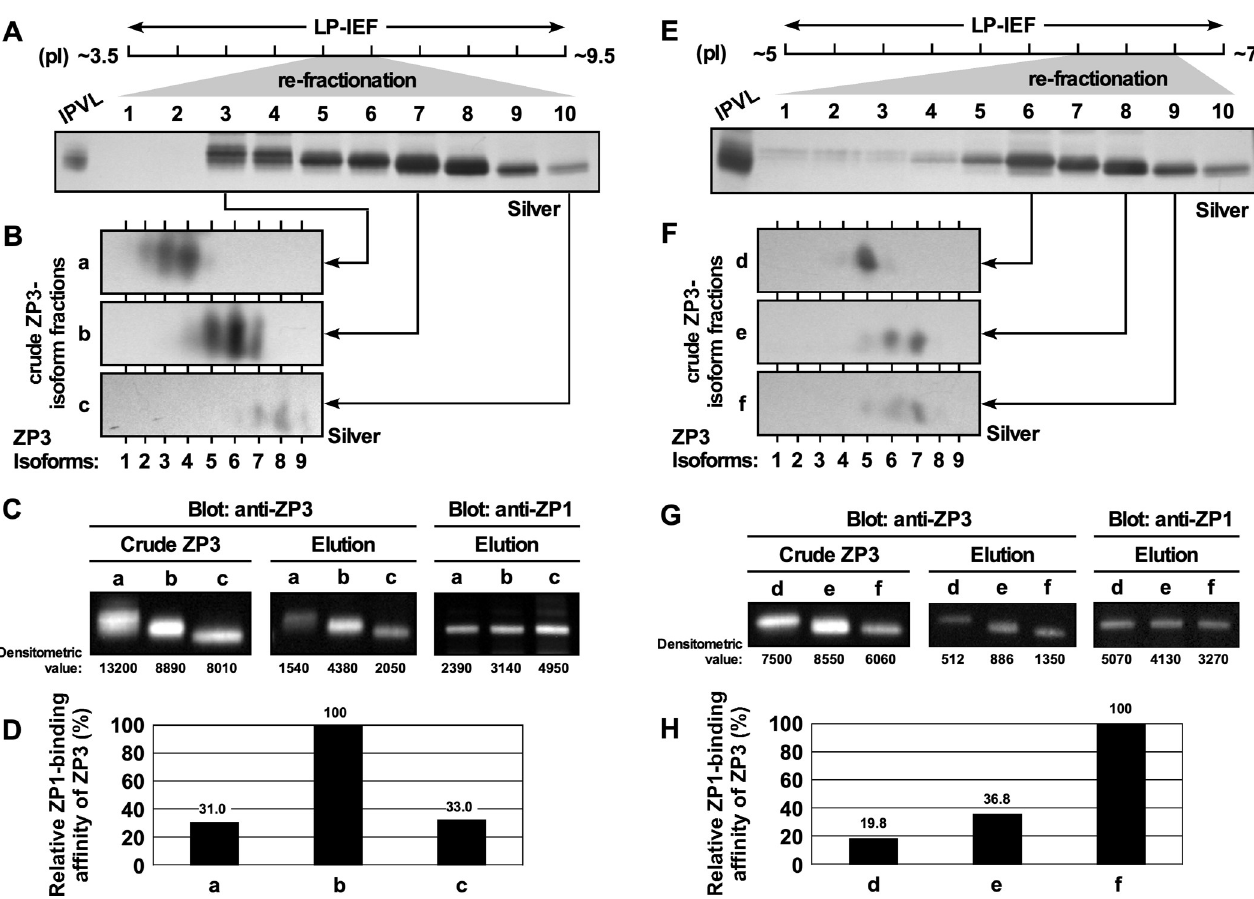
Fig 6. Distinct differences in the ZP1-binding affinities among ZP3 isoforms. IPVL of the commercial White-Leghorn hens that were isolated from the yellow follicle F1 were subjected to the preparative liquid-phase isoelectric focusing (LP-IEF) using the carrier ampholyte for pH ranges of ~3.5–9.5 followed by the re-fractionation procedure (A and B), and ZP1-binding affinities of ZP3 isoforms in the fractions were assayed as mentioned in the Materials and Methods section (C and D). Similarly, ZP1-binding affinities were assayed for ZP3 isoforms that were fractionated by LP-IEF of the IPVL using the carrier ampholyte for pH ranges of ~5–7 followed by the re-fractionation (E–H). (A and E) Silver-stained non-reducing SDS-PAGE gel images of each 10 fractions obtained from the re-fractionation procedures are extracted to contain ZP3 bands (~36 kDa). IPVLs were subjected to the left-side lanes of the fractions 1 as controls. The approximate pH ranges and fraction numbers of the re-fractionation are shown on the top. (B and F) Silver-stained 2D-PAGE gel images of the fractions 3, 7, and 10 that are seen in A (renamed as the crude ZP3-isoform fractions a, b, and c, respectively) and the fractions 6, 8, and 9 that are seen in E (renamed as the crude ZP3-isoform fractions d, e, and f, respectively) are extracted along the horizontal length of the gel ranging from pI ~4 to ~7 to contain ZP3-isoform spots (~36 kDa). The horizontal positions of the spots of ZP3 isoforms are indicated on the bottom with vertical lines . (C and G) Immunoblots for both the crude ZP3-isoform fractions (the left 3 lanes labeled as "Crude ZP3") and the elution fractions (middle 3 lanes labeled as "Elution") using anti-ZP3 antiserum, and that for the elution fractions (the right 3 lanes labeled as "Elution") using anti-ZP1 antiserum are extracted to contain ZP3 (~36 kDa) or ZP1 (~97 kDa) signals. The densitometric values for the blots are shown on the bottom. (D and H) The "Elution"/"Crude ZP3" ratios of the densitometric values of ZP3 signals are calculated and normalized for the corresponding values of ZP1 signals in the "Elution". The relative ratios are displayed by bar graphs as the "relative ZP1-binding affinity of ZP3 (%)". The values of relative ratios are shown on the top of the bars .